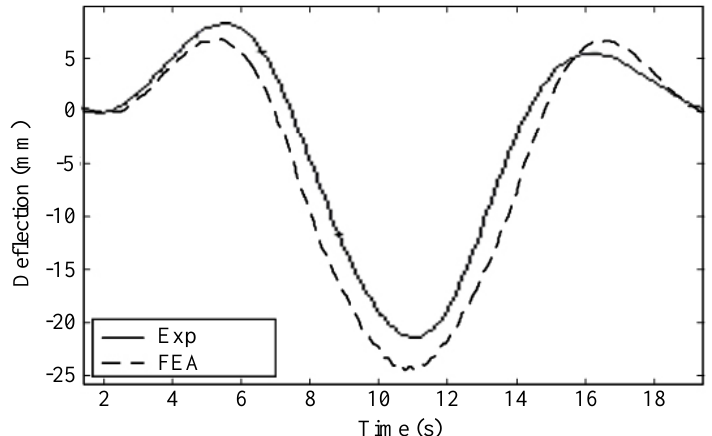
Figure 16. Comparison of numerical and measured deflection histories at the mid-span of the central span with one freight train passing through the bridge at 80 km/h.